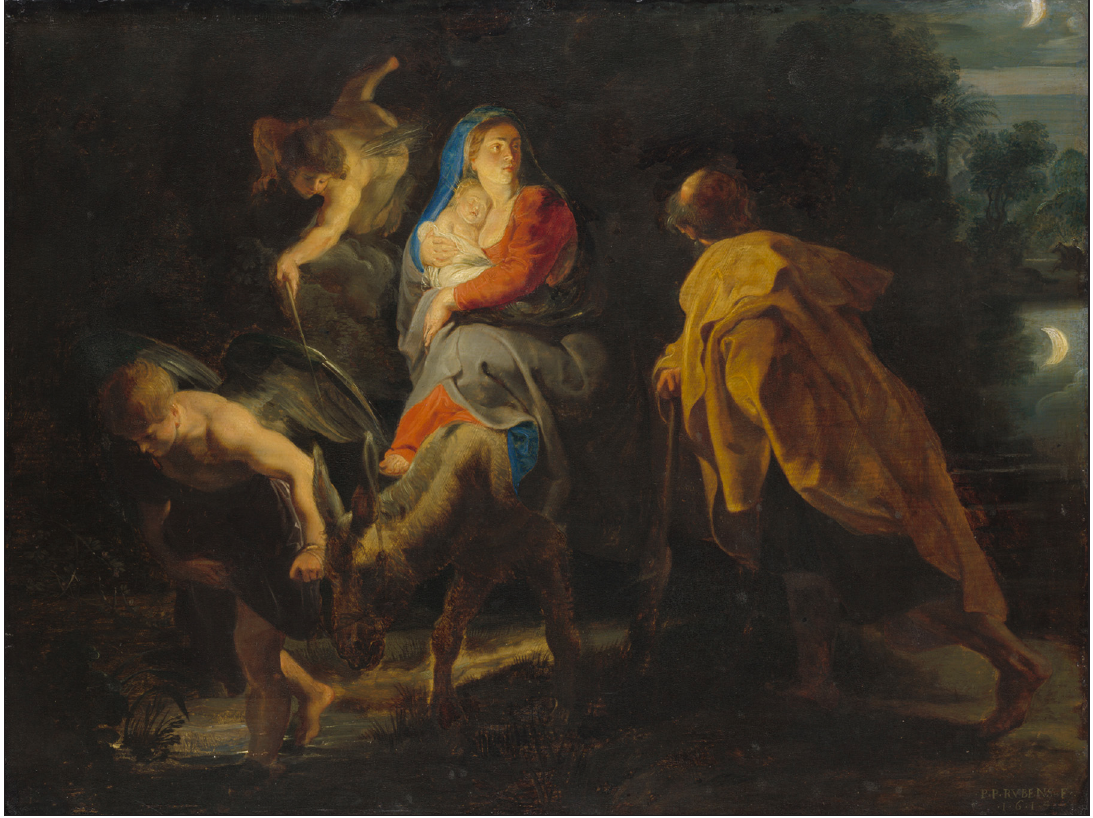
Figure 7: Peter Paul Rubens, The Flight into Egypt , 1614, oil on panel, 40.5 × 53 cm. © Museumslandschaft Hessen